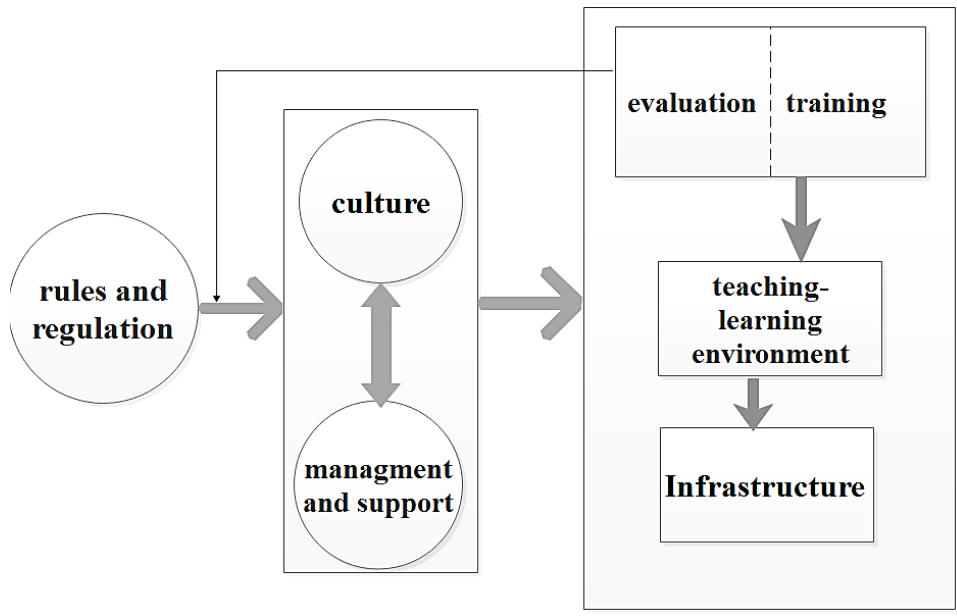
Figure 1. Intelligent school